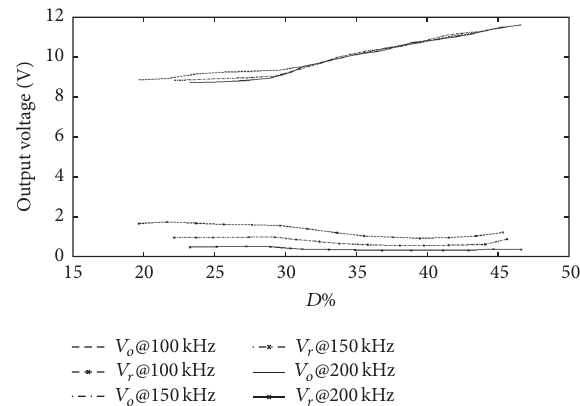
Figure5:Plotoftheeffectivecapacitance 𝐶 𝑑 versustheloadcurrent. Figure 6: The output DC ( 𝑉 𝑜 ) and ripple ( 𝑉 𝑟 ) voltage versus the duty cycle for different